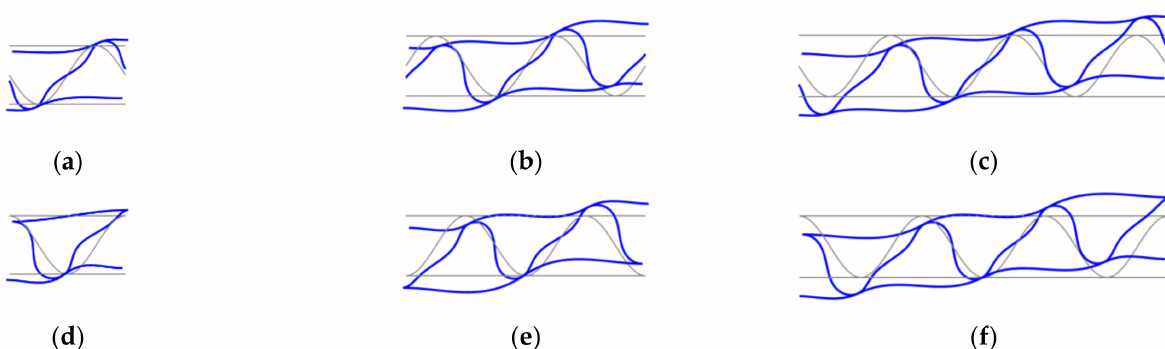
Figure 8. Deformation of RVE cross-section under transverse shear strains for different numbers of periods of corrugated cardboard for unsymmetric fluting cardboards: ( a ) 1, ( b ) 2, and ( c ) 3 periods; and symmetric fluting cardboards: ( d ) 1, ( e ) 2, and ( f ) 3 periods.